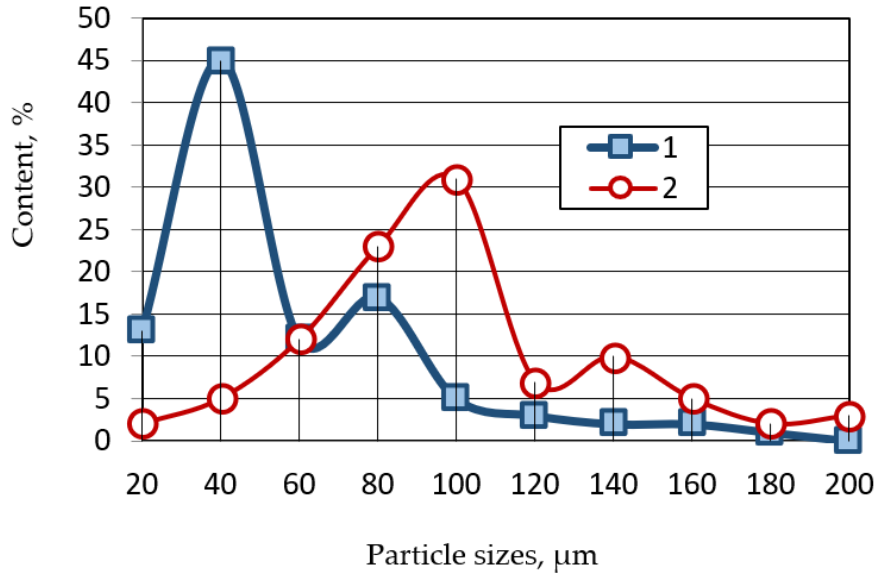
Figure 2. Fractional composition of thermal energy waste: 1—fly ash; 2—aluminosilicate microsphere. Humidity of fly ash and aluminosilicate microspheres sent by the supplier should be no more than 1% according to the Russian standard GOST 25818-2017. Humidity of thermal power waste used in experiments was determined by drying samples of materials to constant weight at a temperature of 110 ◦ C. In the experiments, it used thermal energy waste with a natural moisture content of 0.5–0.8